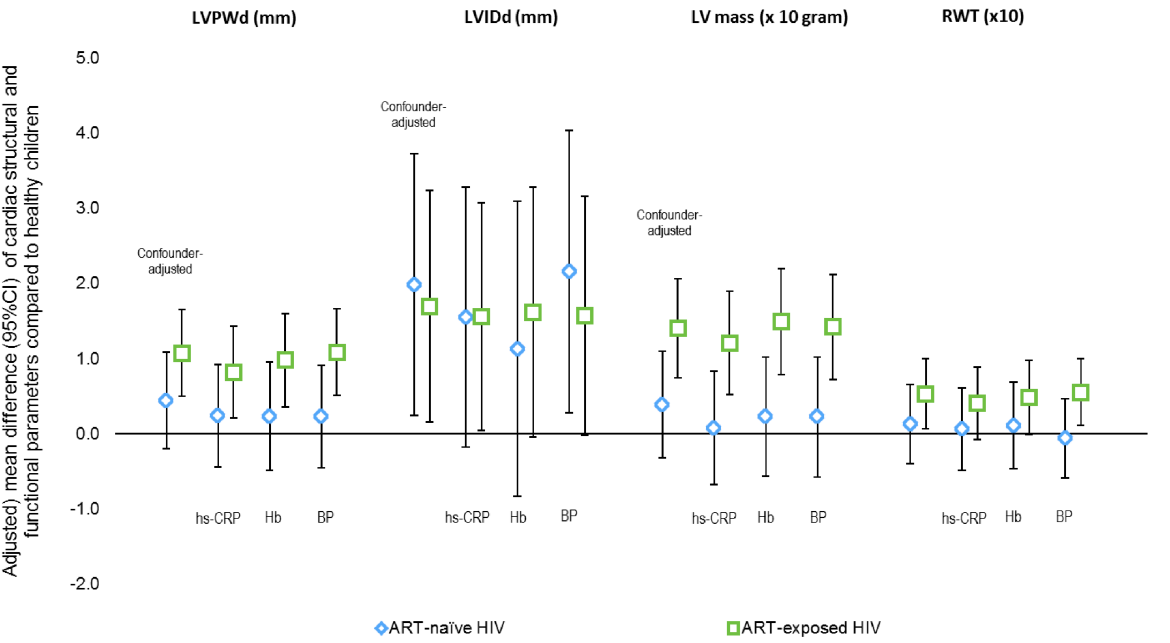
Fig 1. Influence of potential explanatory variables on cardiac structural estimates in ART-naive and ART-exposed HIV infected children. Note: LVPWd = left ventricular posterior wall thickness at end-diastole; LVIDd = left ventricular internal diameter at end-diastole; LV mass = left ventricular mass; RWT = relative wall thickness; Hb = hemoglobin level; BP = systolic and diastolic blood pressure.